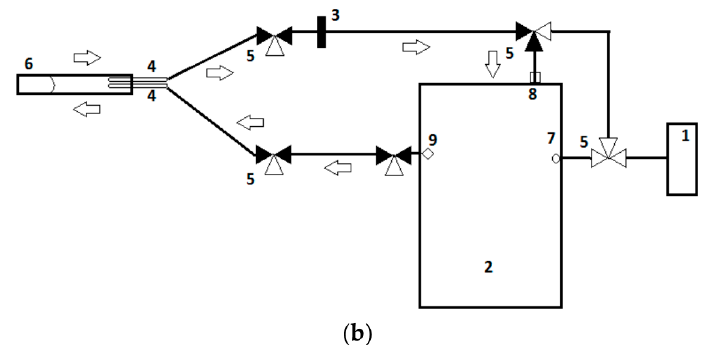
Figure 1. A schematic illustration of electronic nose setup during: ( a ) purging of the sensors and subsequently obtaining a baseline reference signal and ( b ) performing the actual sample measurement. A dark cone in a three-way valve (number 5) illustrates an air flow can pass, while a white cone prevents this. The arrows depict the air flow through the measurement setup. ( a ) First, the sensors are purged for 90” with filtered air derived from ambient air passing the A1-filter. The airflow, containing the residual volatile organic compounds (VOC), detached from the sensors, and is expelled through the exhaust port. Subsequently, a baseline reference signal is obtained in 30” using filtered air. ( b ) After the baseline reference signal is obtained, the actual measurement takes place in 60”. By rotating several three-way valves, a closed loop in connection with the fecal sample is formed ( 6 ). This loop prevents dilution of fecal VOCs with ambient air and, moreover, causes a continuous flow of fecal VOC passing the sensors. After the measurement, the three-way valves are rotated back to their original positions (Figure 1a) and the sensors are purged. ( 1 ) A1 filter, ( 2 ) Cyranose320 ® , ( 3 ) Polyethersulfone filter, ( 4 ) blunt needle, ( 5 ) three-way valve, ( 6 ) a vacutainer containing feces, ( 7 ) purge inlet, ( 8 ) sensor inlet, ( 9 ) exhaust portal, and ( 10 ) oxygen hose. Adapted with permission from Berkhout et al., 2016, Supplementary Material [54].